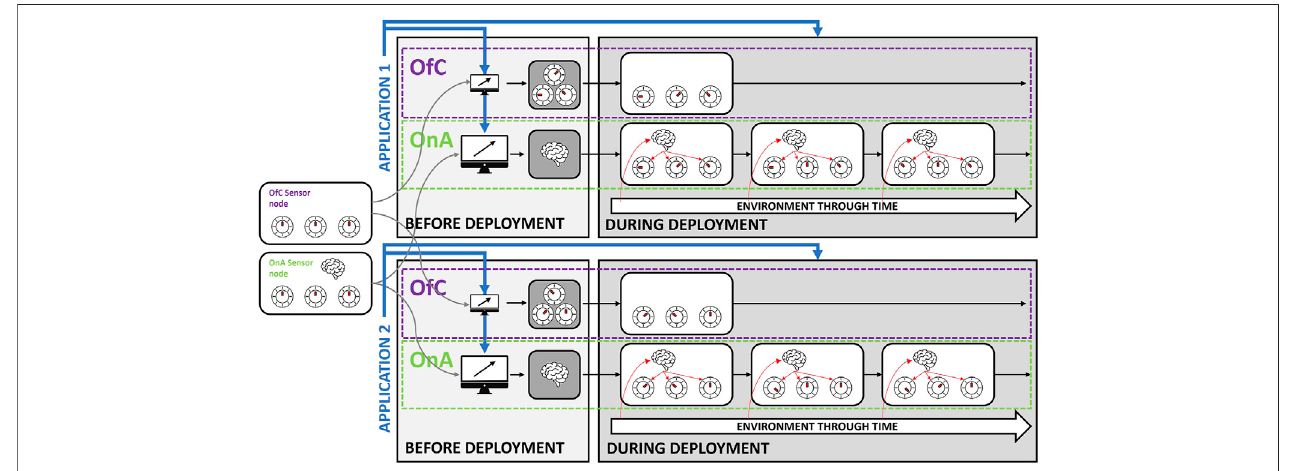
FIGURE2| Thedifference between of fl inecon fi gurability and onlineadaptivity:a fl exible platform isused forboth OnA and OfC.Before deployment,static settings arecon fi guredforOfC,whileanadaptivestrategyisprogrammedontothe fl exibleplatformsforOnA.Duringemployment,thesettingsofOnAcan,hence,change,based on a changing environment.